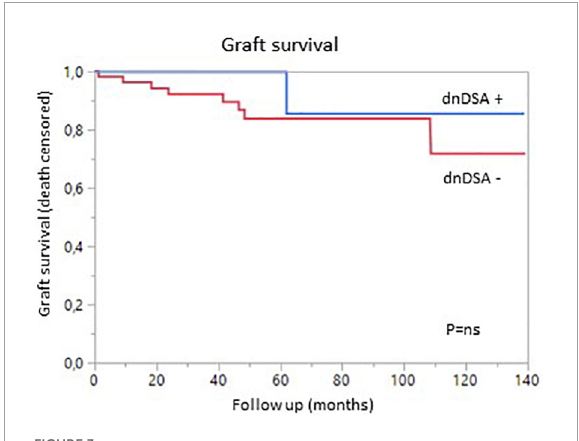
FIGURE3 Graft survival (death-censored) according to the presence (blue) or absence (red) of de novo